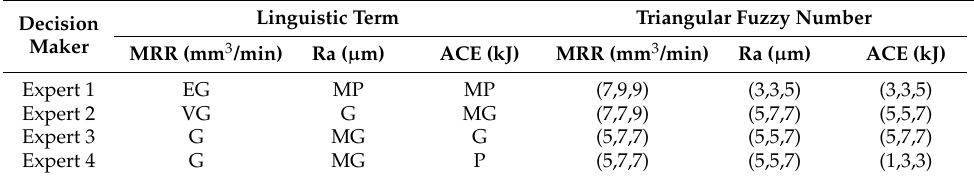
Table 9. Experimental dataset on green dry milling of AISI 1045 steel (case study